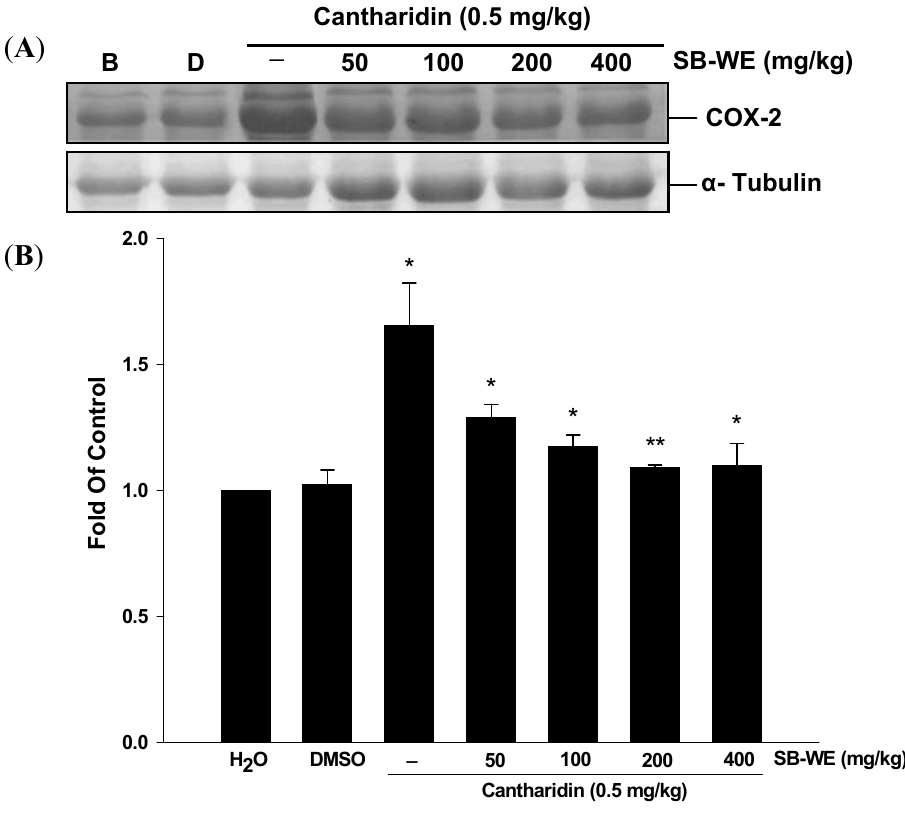
Figure 5. Effects of the boiling-water extract of S. baicalensis (SB-WE) against cantharidin-induced rat cystitis and correlated with ( A ) Western blot and ( B ) quantitative analysis (B) of COX-2 protein expression. B, blank; D, DMSO. * p < 0.05, ** p < 0.001, n =